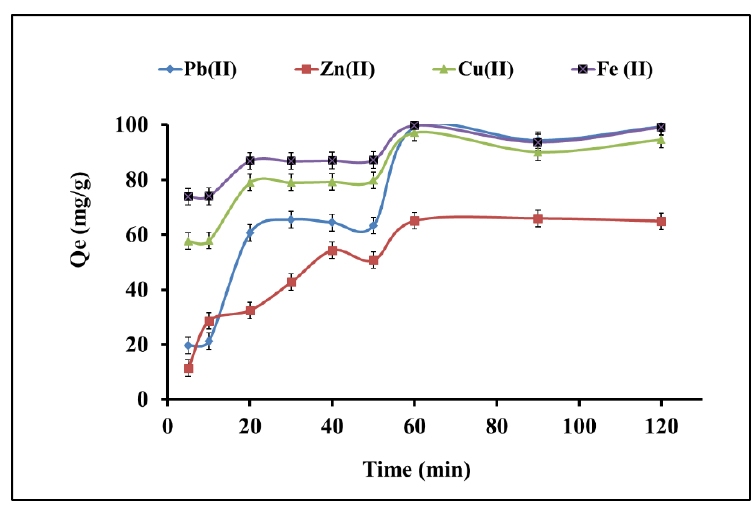
Figure 3. The effect of contact time on the adsorption of Pb(II), Zn(II), Cu(II), and Fe(II) onto 0.05 g of RC-MWS.